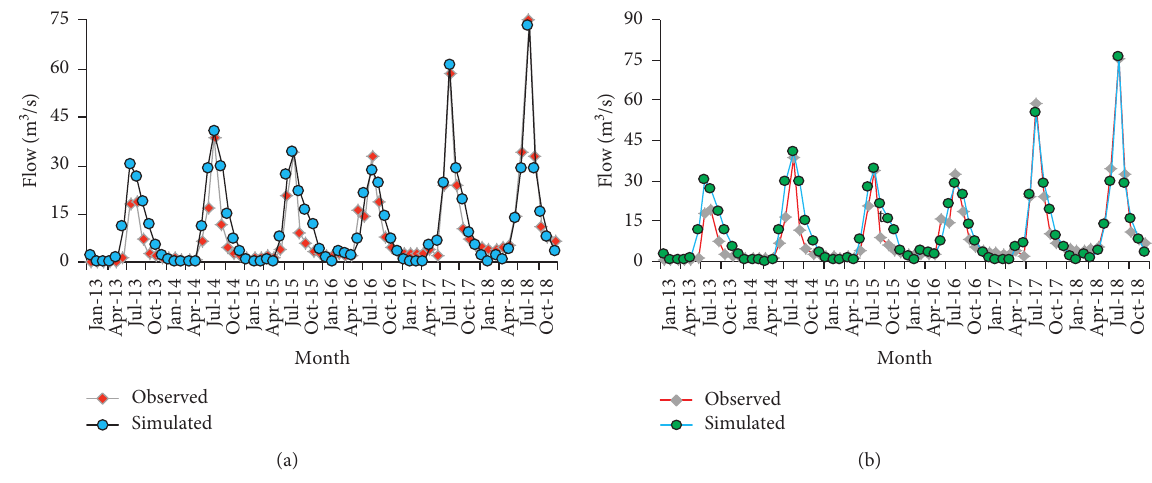
Figure 13: Stream flow comparison for validation periods (a) 1998 LULC and (b) 2016 LULC. Table 9: Measures of model performance for